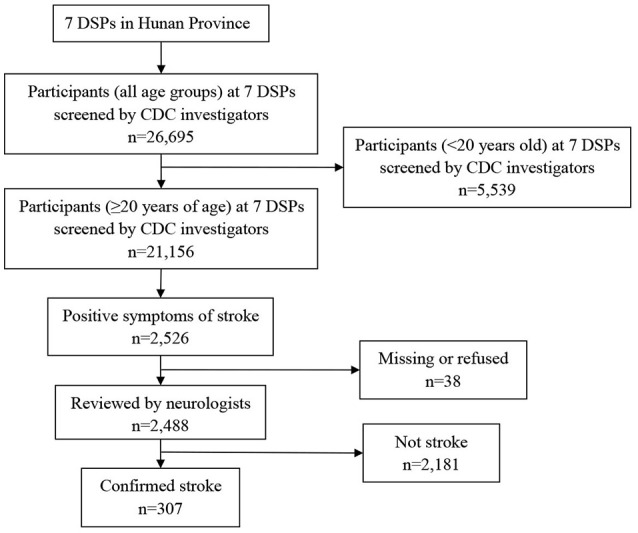
Flowchart of stroke case evaluation.